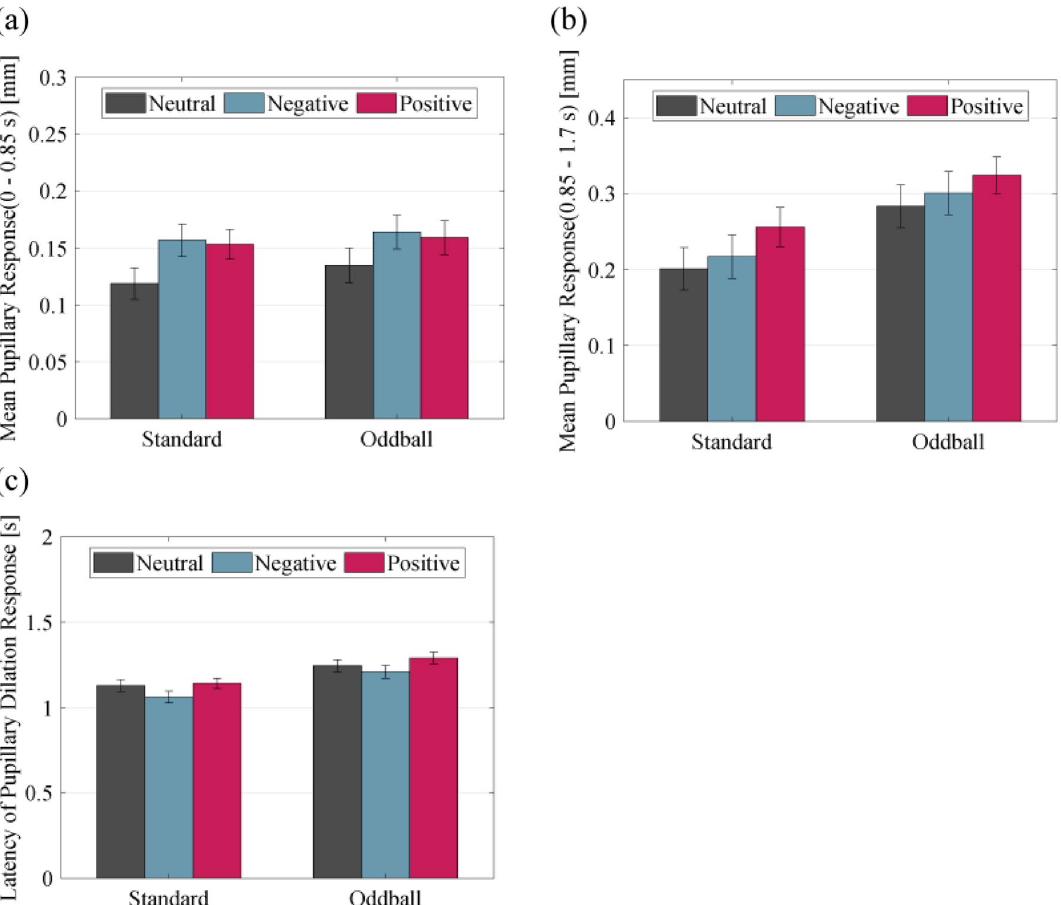
Figure 3. The pupillary dilation response (PDR) components. ( a ) The early component (mean PDR between 0 and 0.85 s). ( b ) The late component (mean PDR between 0.85 and 1.7 s). ( c ) The PDR latency between tone onset and peak PDR amplitude. The error bars indicate the standard error of the